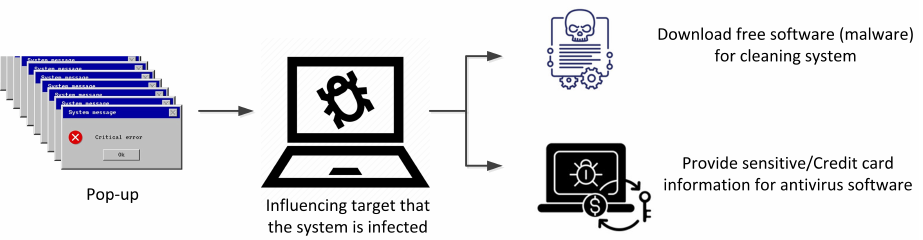
Figure 4. Steps of a scareware attack.